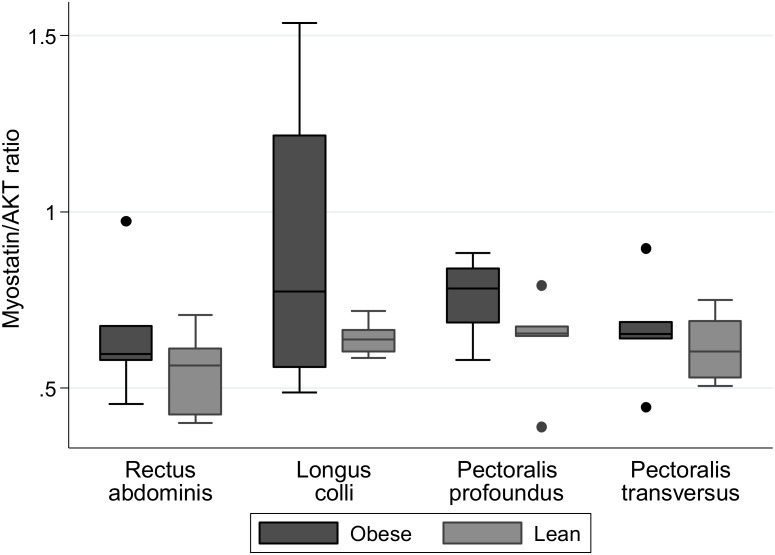
Protein expression of Myostatin precursor protein in skeletal muscles of lean and obese horses and ponies.Protein expression of myostatin precursor protein (∼45 kDa) was assessed by Western blot with total AKT used as a loading control. Mean densitometric signals were calculated from three independently repeated Western blots. n = 6/group.